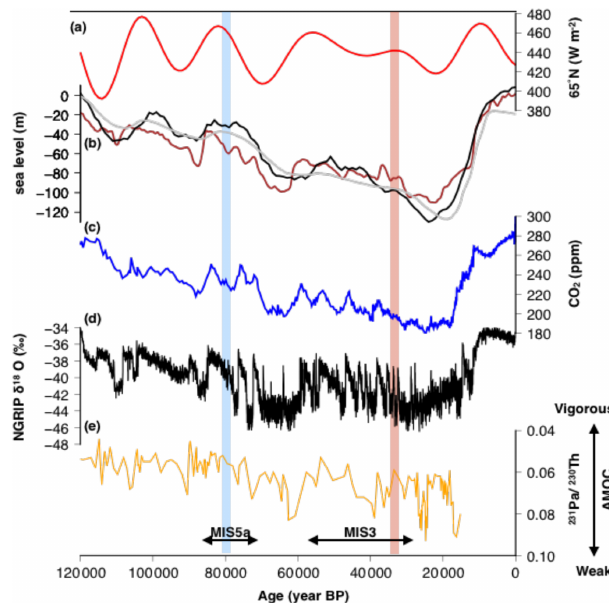
Figure 1. Time series of climate records of the last glacial period: panel (a) shows the 65 ◦ N July insolation (Wm − 2 ); in panel (b) , black represents sea level data from Spratt and Lisiecki (2016), brown represents sea level data from Grant et al. (2012), and gray represents the simulated time evolution of the sea level equivalent ice sheet volume from Abe-Ouchi et al. (2013); panel (c) shows CO 2 (Bereiter et al., 2015); panel (d) shows the Greenland ice core δ 18 O from the North Greenland Ice Core Project (NGRIP) core (Rasumussen et al., 2013). Panel (e) shows the Bermuda Rise 231 Pa / 230 Th (Bohm et al., 2015), which is a proxy for the strength of the AMOC. Red and blue shading correspond to the MIS3 and MIS5a target periods in our climate model simula- tions,